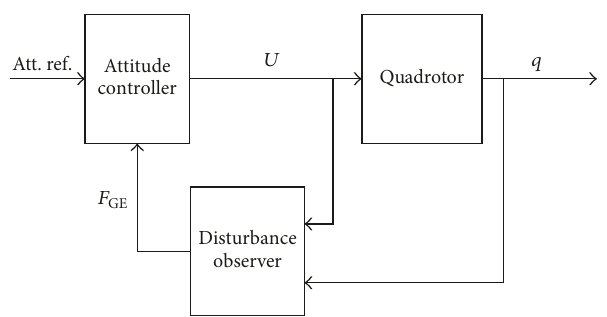
effect torque disturbance is directly related to the relative distance from the rotor to the ground or obstacle. Then, if we can have an estimation of this relative distance, it is possible to implement a feedforward control approach that allows canceling the torque disturbance partially. The block diagram of this approach is represented in Figure Figure 16: Estimated torque controller.